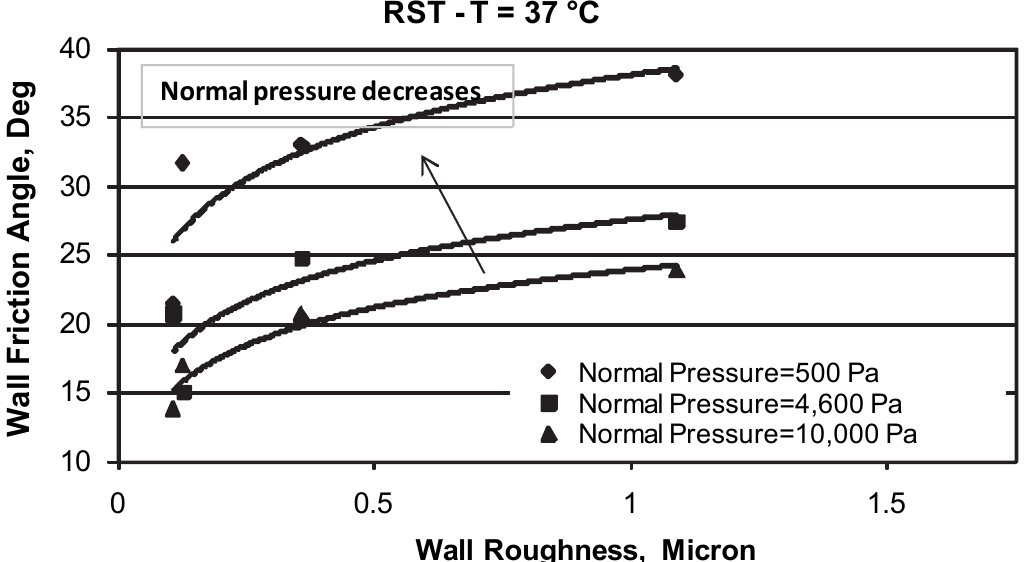
Fig. 7 Wall Friction Angle vs. Wall Roughness (RST at 37 ℃ ).